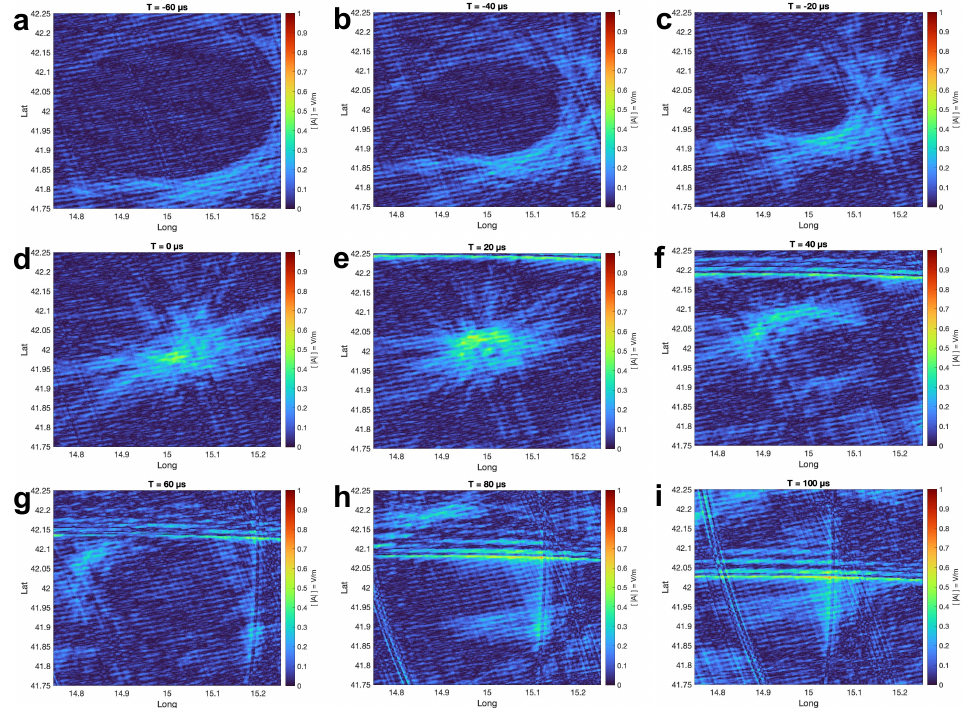
Figure 15. The scaled amplitude maps with a small receiver network with a simulated lightning location of 15°E and 42°S ( N =